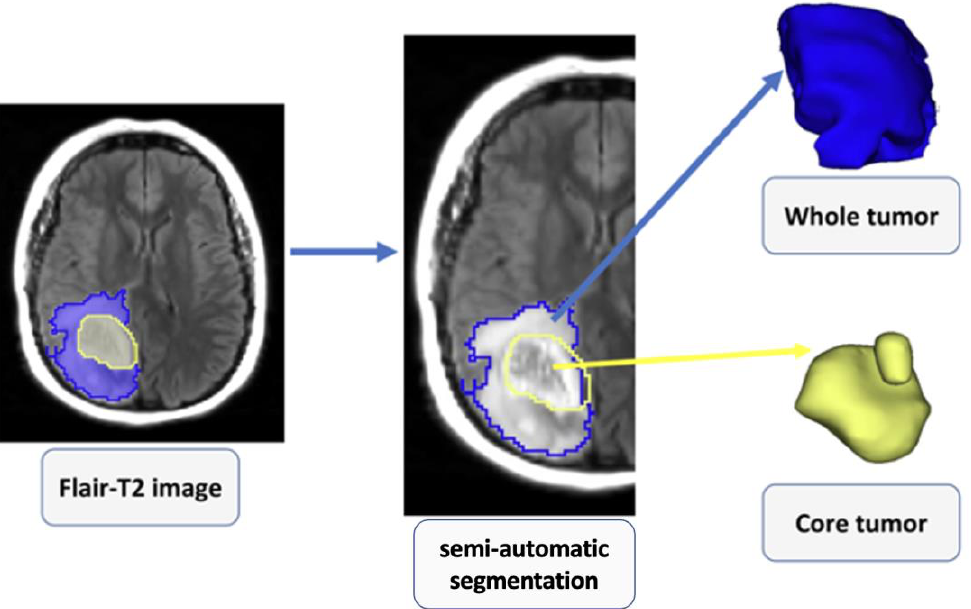
Figure 3. 2D and 3D visualization of various subregions of a grade 4 astrocytoma as visible on T2-FLAIR image.